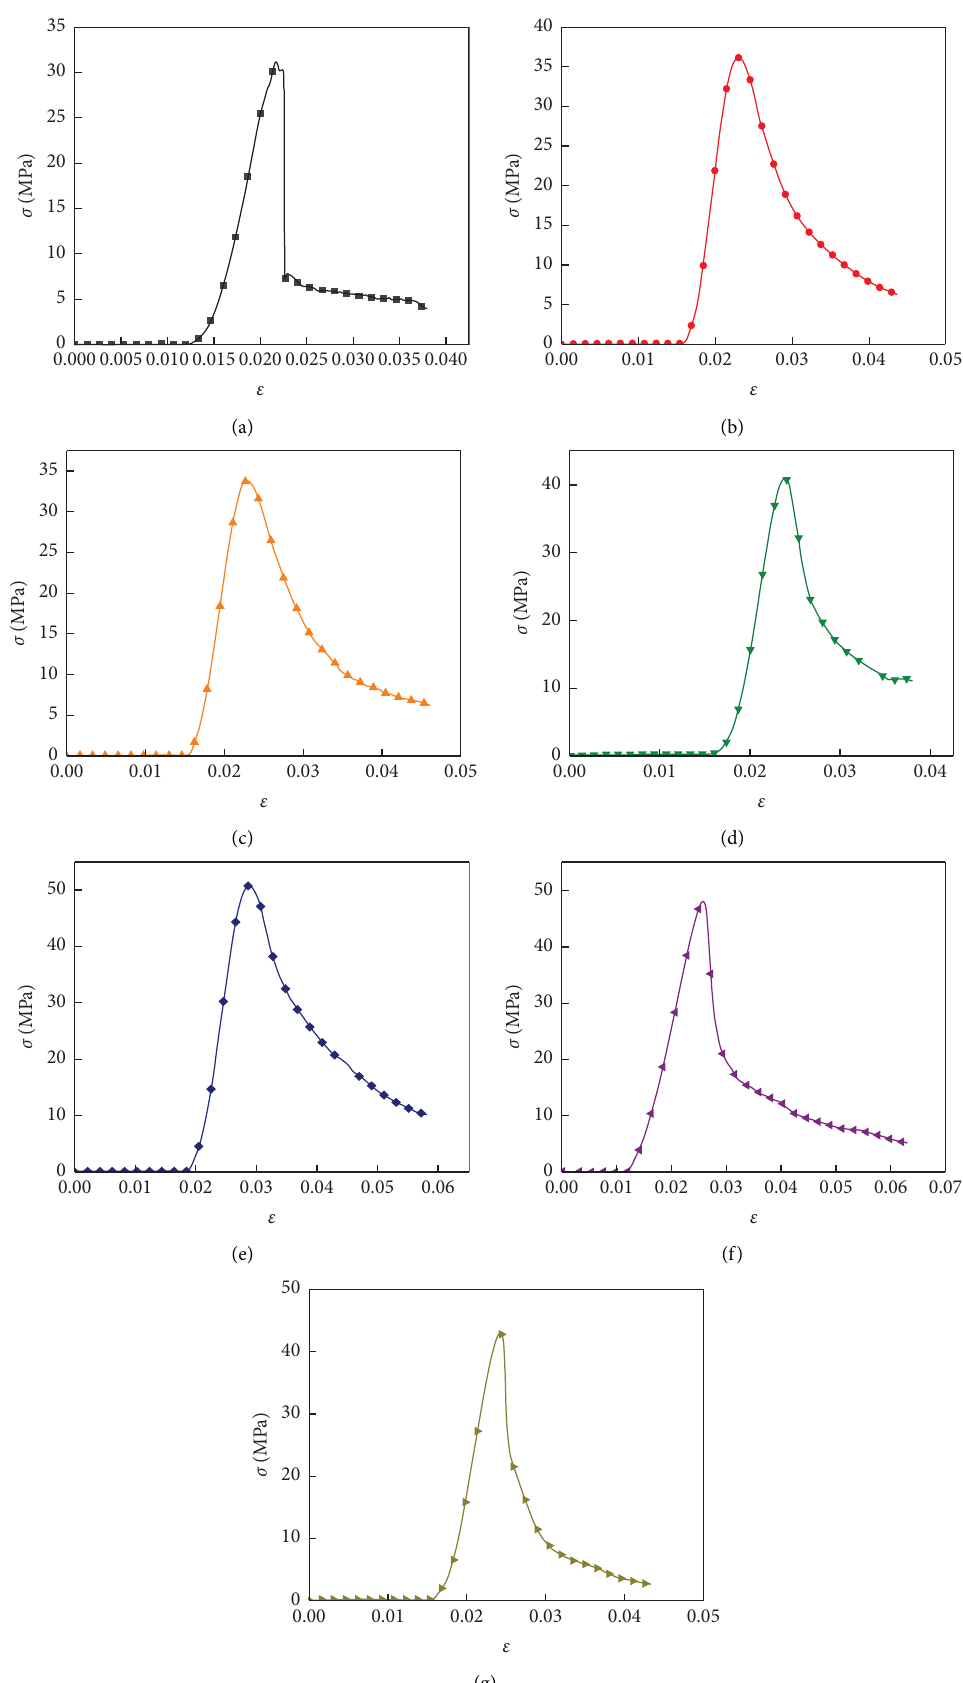
Figure 5: Stress-strain curve. (a) OC group. (b) BF-0.1 group. (c) PF-0.1 group. (d) HC-0.1 group. (e) HC-0.2 group. (f) HC-0.3 group. (g) HC-0.4